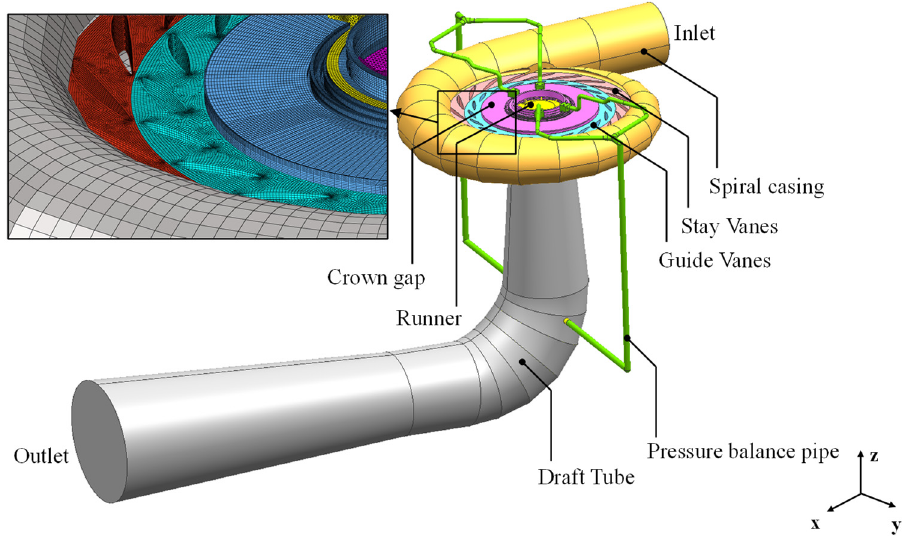
Figure 1. CFD domain and mesh of pump–turbine.